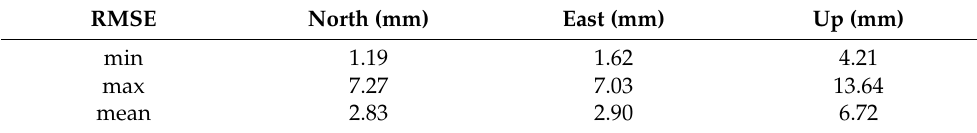
Figure 9. Influence of tau selection (a. true × 0.1, b. true × 10, c. true × 1.0) on the post-seismic deformation model with different combinations (a. Offset + Velocity, b. Offset + Velocity + PSD, c. Offset + Velocity + PSD + Period). Table 3. The fitting RMSE (Root Mean Square Error) of the GNSS sites impacted by seismic